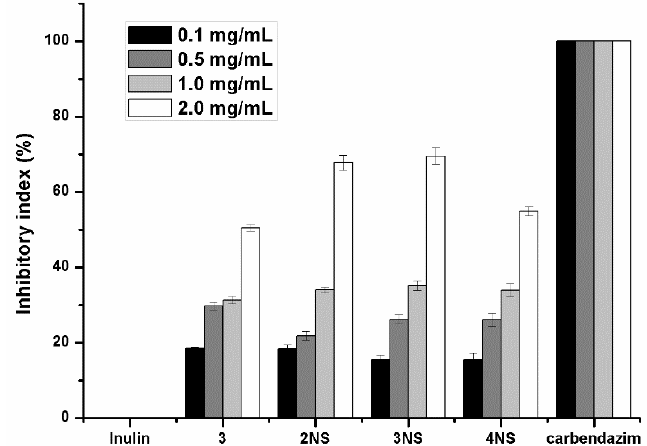
Figure 6. Antifungal activity of inulin and the inulin derivatives against P. asparagi.